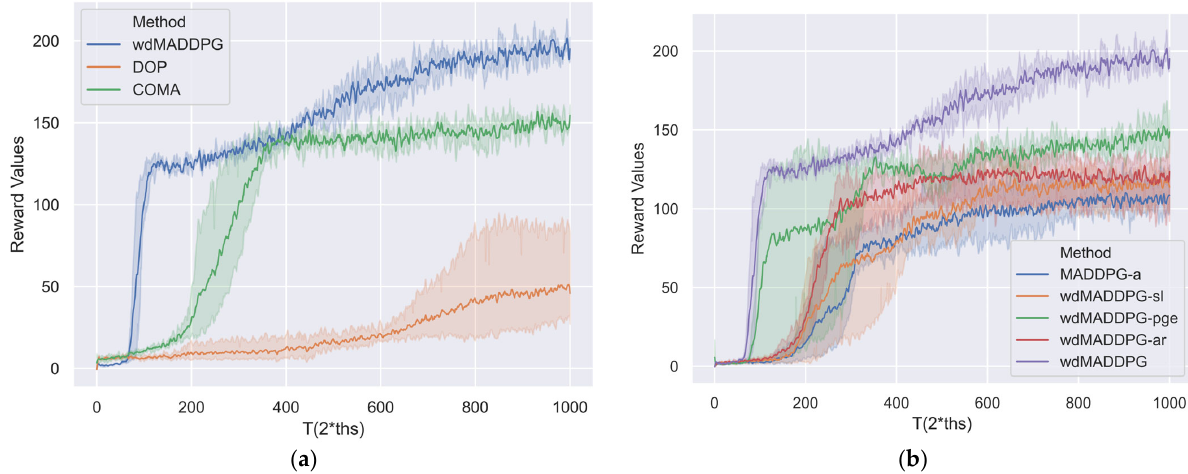
Figure 10. Mean reward values of different wargame decision-making methods and other methods based on the AC framework. The mean of reward values across five seeds is plotted and the 95% confidence interval is shown as shaded. ( a ) Comparison experiments with other methods are based on the AC framework; ( b ) Ablation experiments.